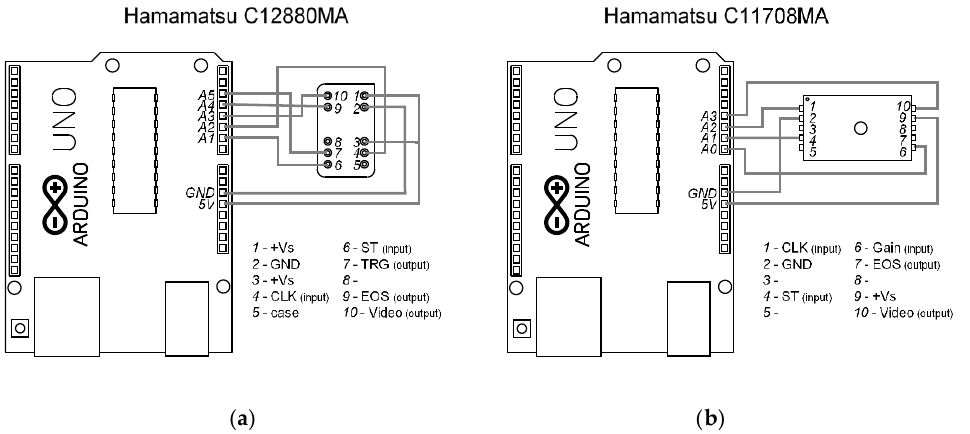
Figure 5. Connection diagram of Hamamatsu C12880MA ( a ) and C11708MA ( b ) micro-spectrometers to the Arduino UNO microcontroller.